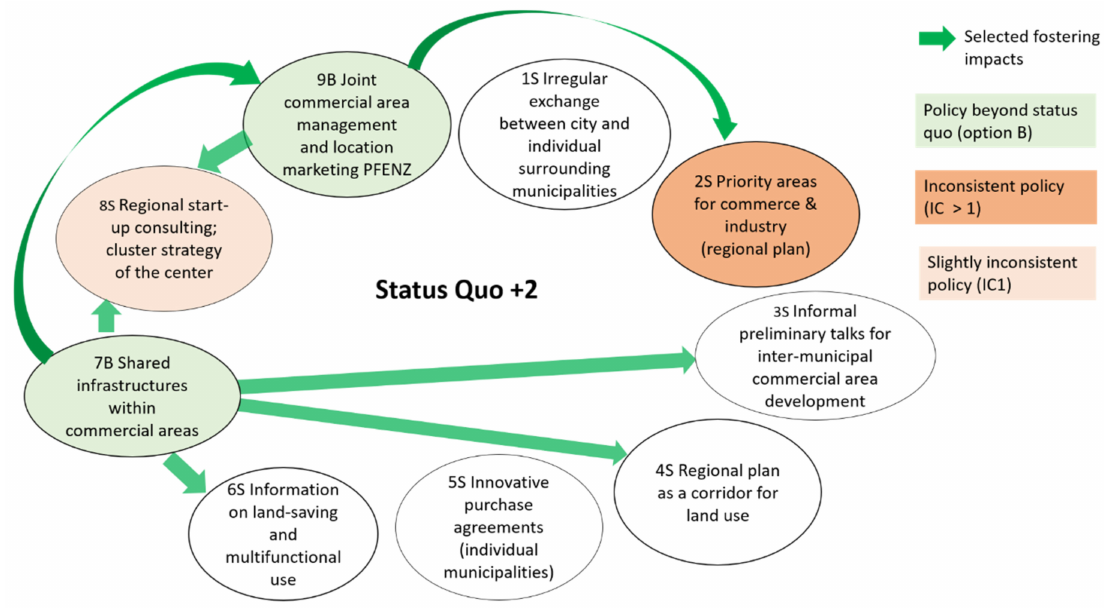
Figure 3. Changing individual policies leads to more mutually fostering relations, but the mix is still inconsistent and not very synergetic (selection of impacts, TIS =